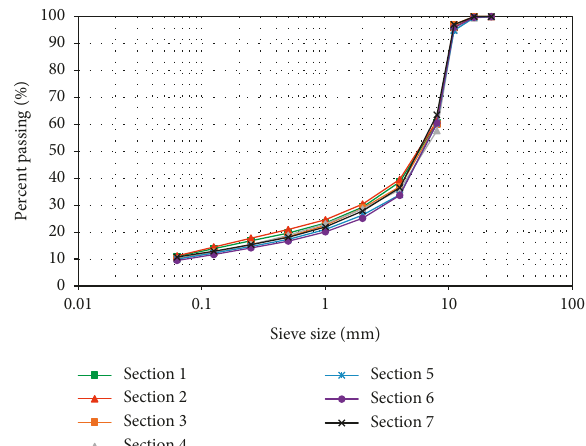
Figure 7: Sieve size distribution of recovered aggregates from test